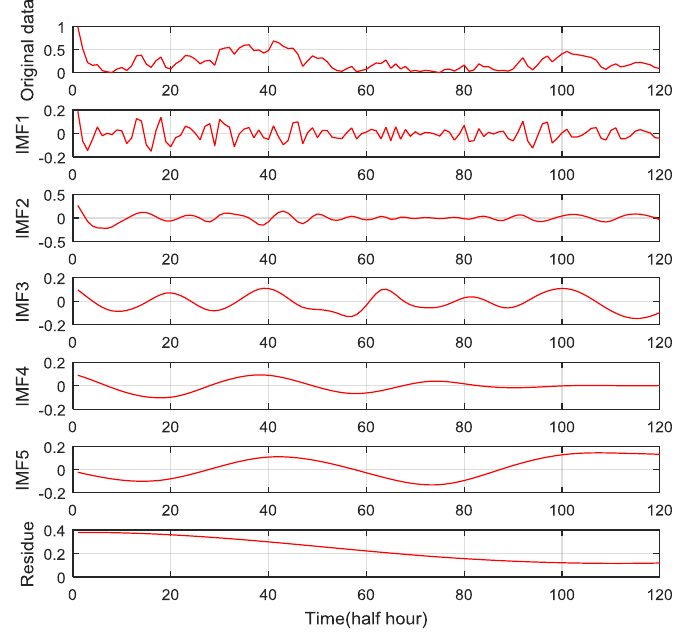
Figure 5. Decomposition results of empirical mode decomposition (EMD).